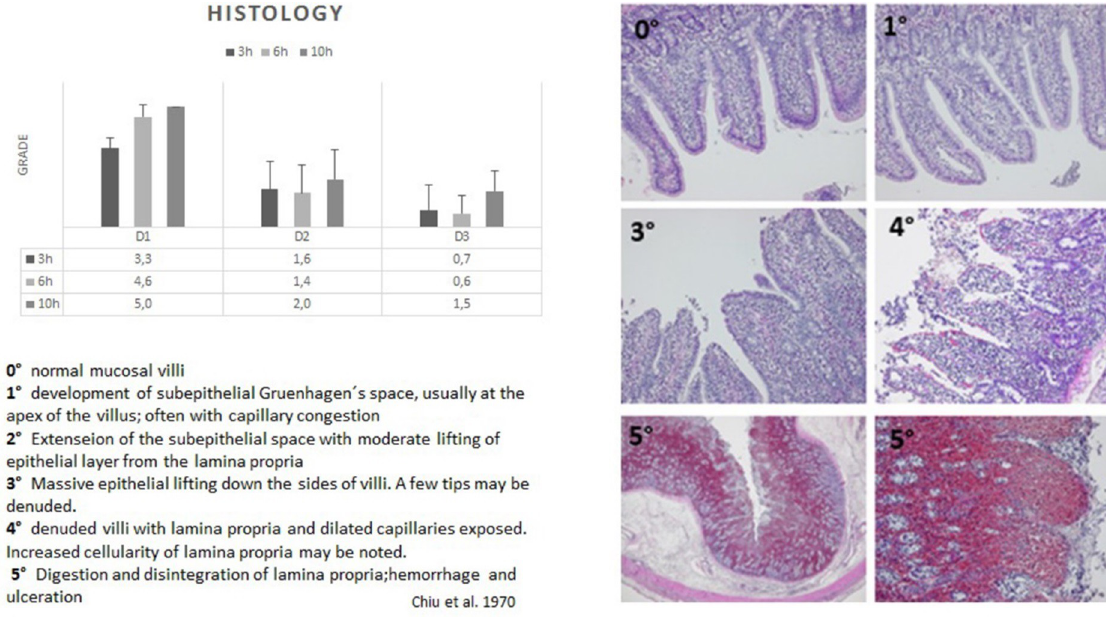
Fig 4. Microscopic findings. Histopathologic examination was performed using the score described previously by Chiu 23,24. Post ischemic bowel showed after 3 h massive epithelial lifting down the sides of villi with denudation of a few tips (grade 3). 6h after ischemia, tissue showed denudation of villi including lamina propria and exposure of dilated capillaries (grade 4), thus indicating principally reversible damages. 10 h of ischemia resulted in digestion and disintegration of lamina propria with hemorrhage and ulceration (grade 5) representing irreversible damage, thus, significantly worse than after 3 h of ischemia (p < 0.05). Transitional zone D2, as well as non-ischemic zone D3 showed mild histopathologic signs of epithelial damage in all groups. The histopathological differences between the ROIs reaches significance (p <